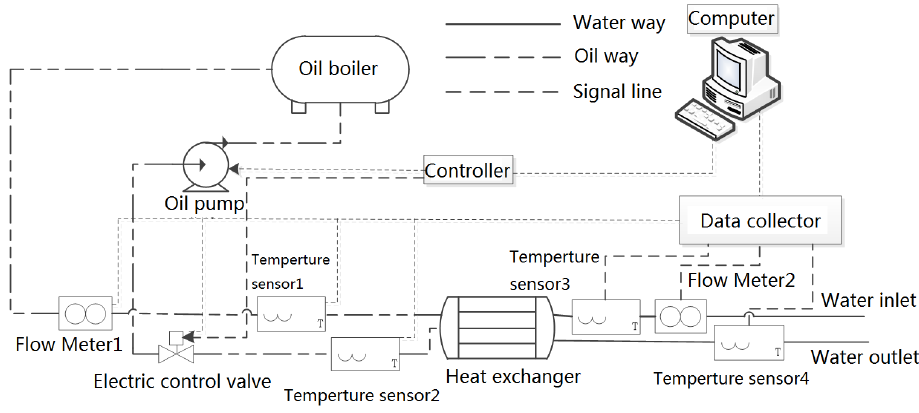
Fig. 6. The working sketch of oil-water side.